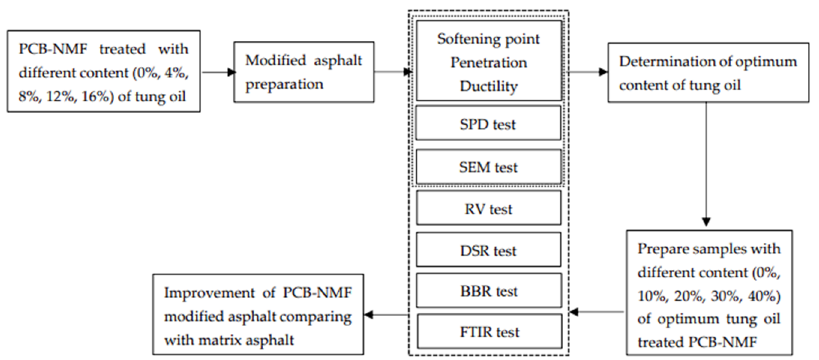
Figure 2. PCB-NMF-modified asphalt test scheme. (1) Scanning electron